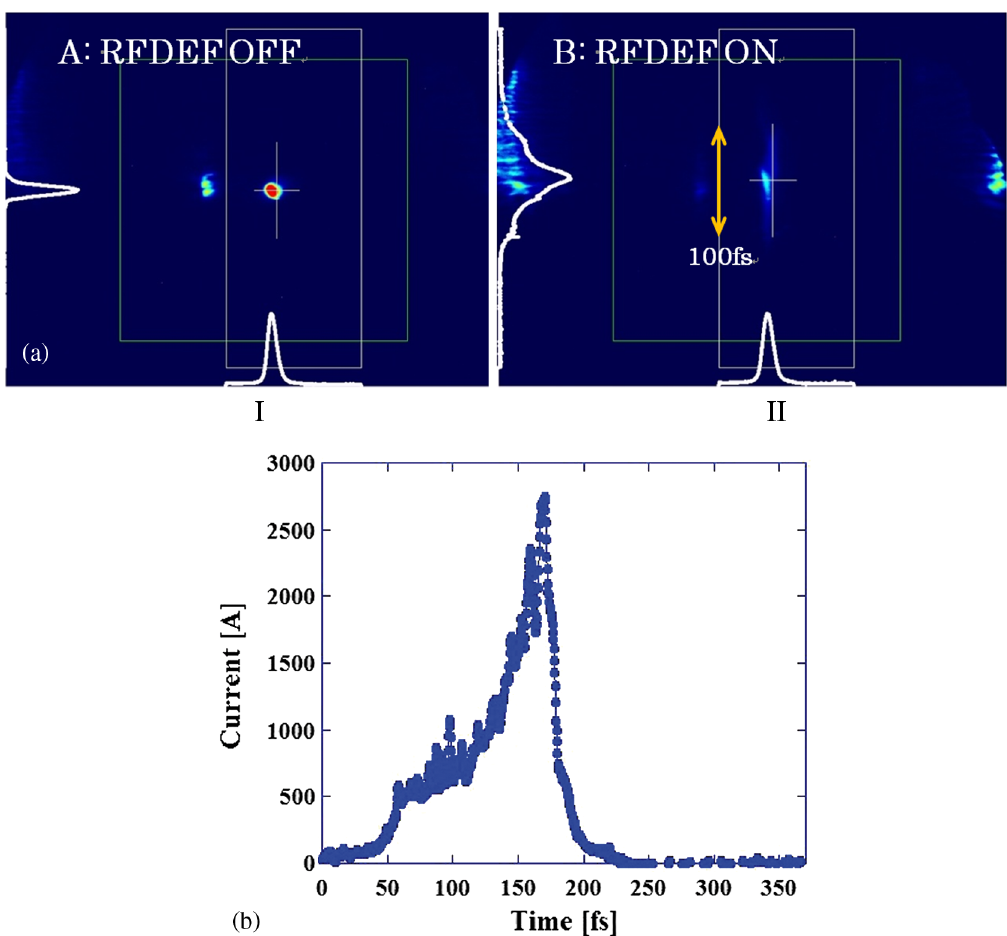
FIG. 29. (a) A, the beam profile (left) taken with the Ce:YAG screen; B, the beam image (right) pitched by the RFDEF and taken with the same screen. (b) Temporal beam-current wave form in Fig. 29(a) taken by the RFDEF system. The bunch length in this case is about 40 fs in FWHM.